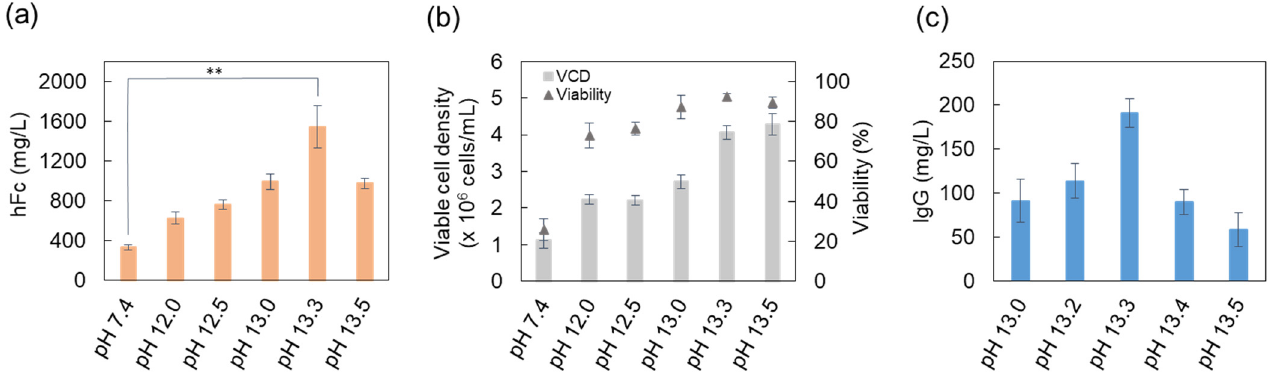
Figure 3. Effect of high pH values of the pDNA solution on the transfection efficiency: ( a , b ) the hFc protein production level and cell condition at 12 days after transfection; ( c ) the bevacizumab production level at 12 days after transfection. Using the liposome formation solution of pH 5.5, pH values higher than 12 for pDNA solution were investigated with pH 7.4 as a control. The results represent the mean ± standard deviation ( n = 3). ** p < 0.01; hFc, human Fc protein; pDNA, plasmid DNA.